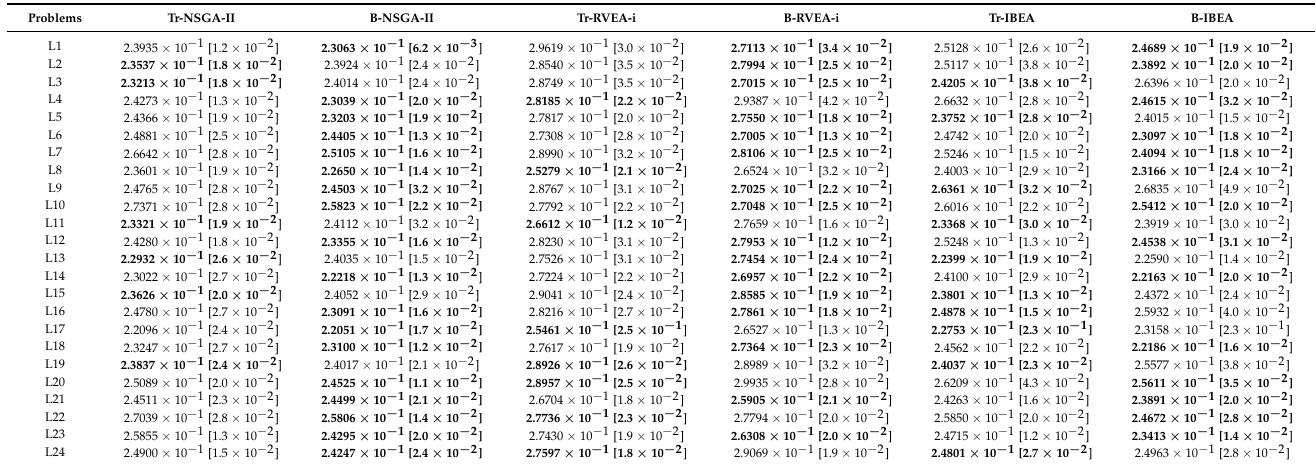
Table 7. Mean and standard deviation values of the MIGD metric obtained by comparing algorithms for large-scale